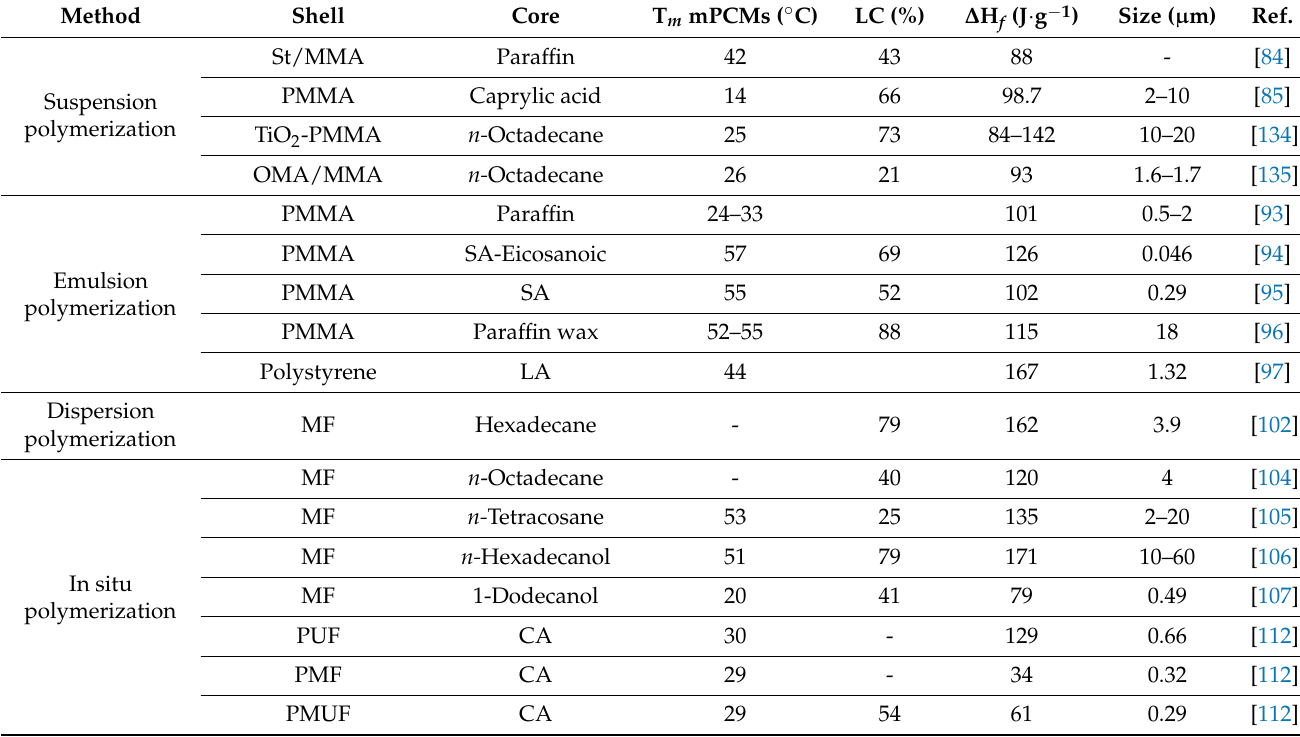
Table 3. Commonly used shell materials in chemical process and mPCMs